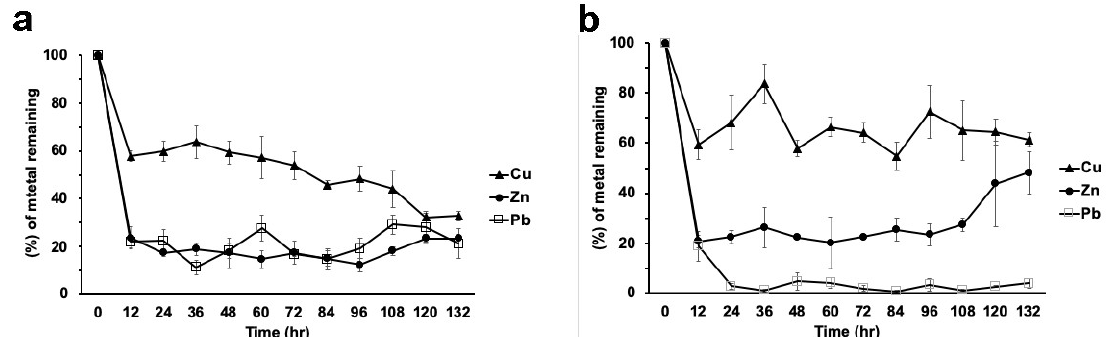
Figure 7. Metal removal from a mixture of metals (100 ppm each) in liquid cultures by strains H17 ( a ) and H21 ( b ). Data is presented as the average amount of metal remaining in the media (%) ± standard deviation (error bars).